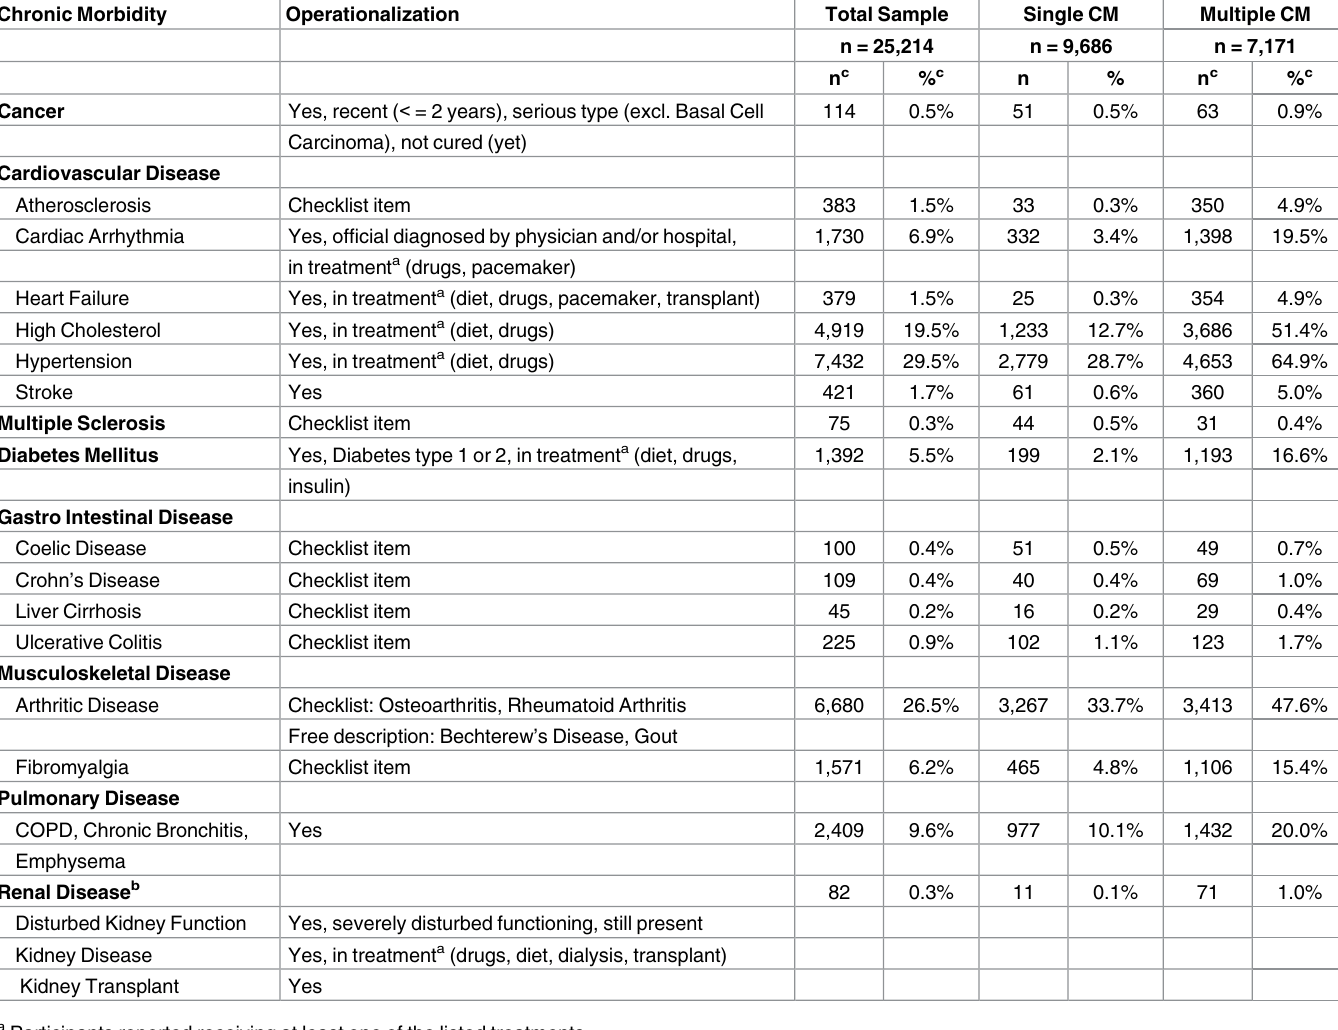
Table 1. Selection and operationalization of chronic morbidity and its distribution across the